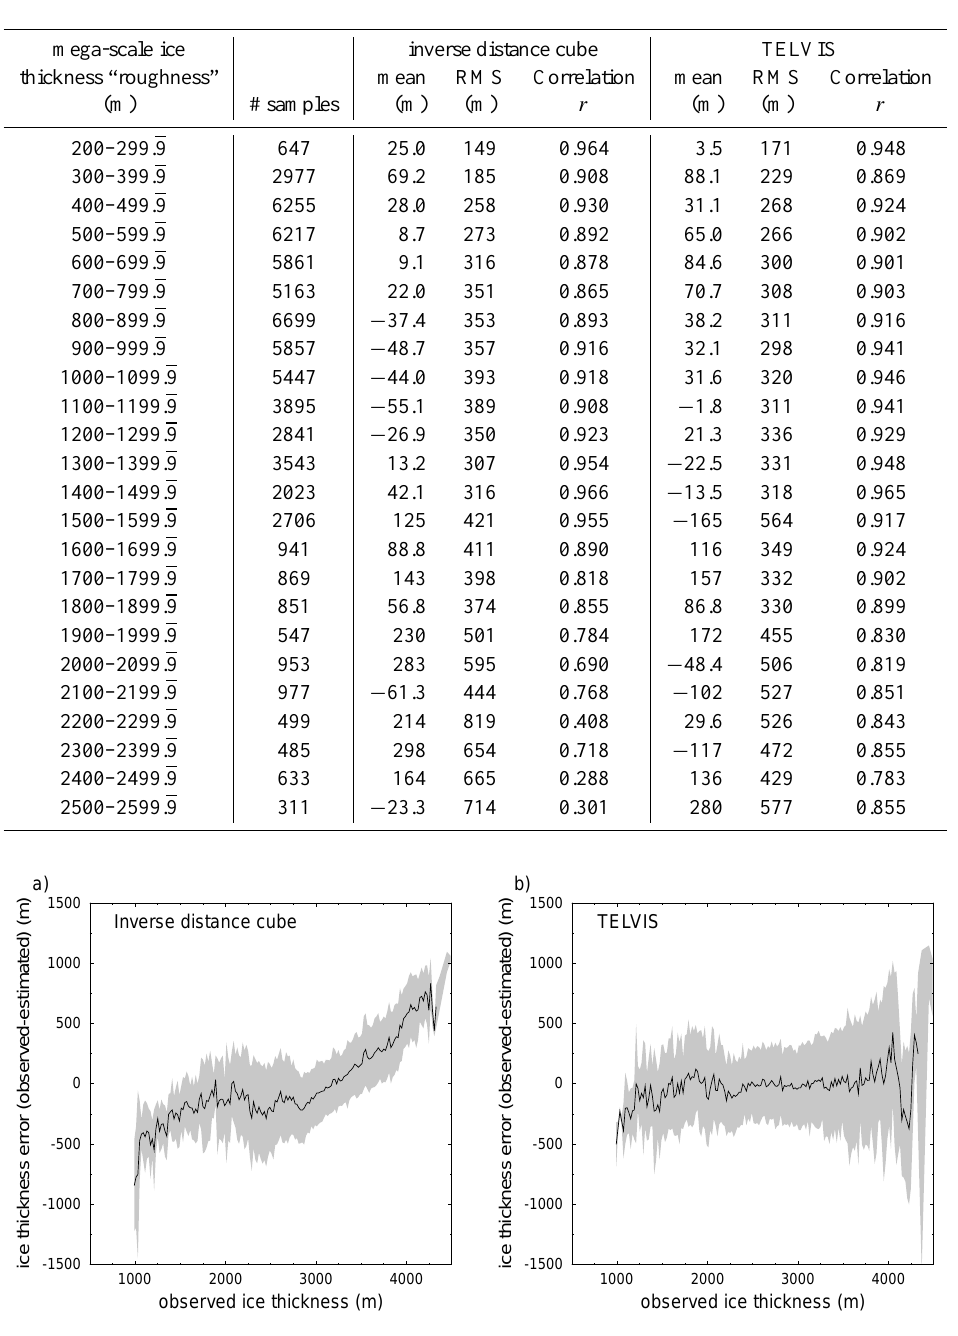
Table 2. Difference between (and correlation with) the ICECAP measured ice thicknesses and the estimated ice thicknesses as a function of mega-scale ice thickness “roughness” using only historical data-sets. r is the Pearson’s correlation coefficient and mega-scale ice thickness “roughness” is the difference between the maximum and minimum smoothed ice thickness within a 50 km radius.